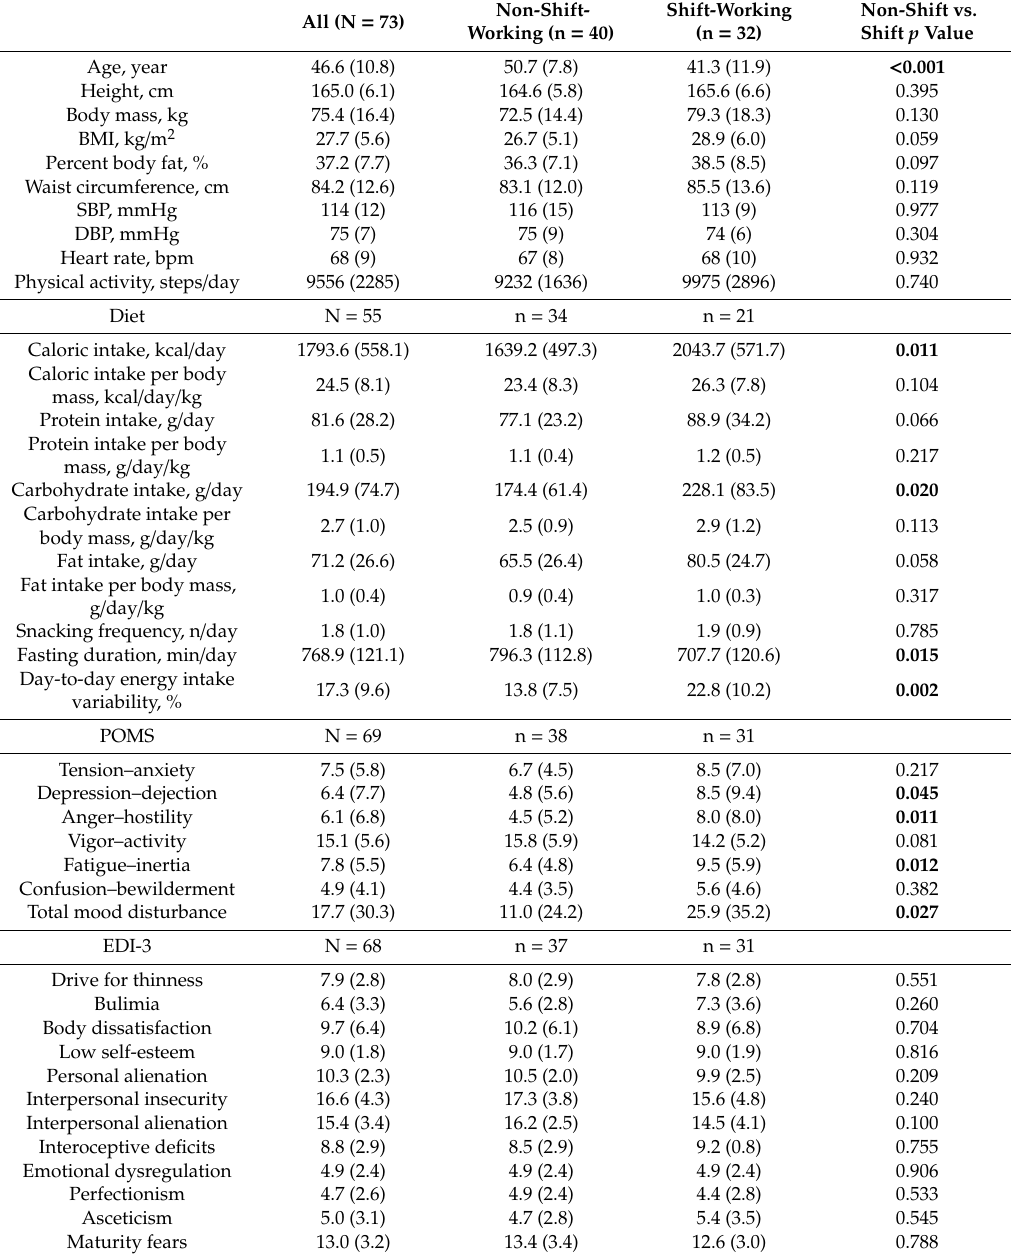
Table 1. Dietary patterns, cardiometabolic and psychological health of female shift-working and non-shift-working